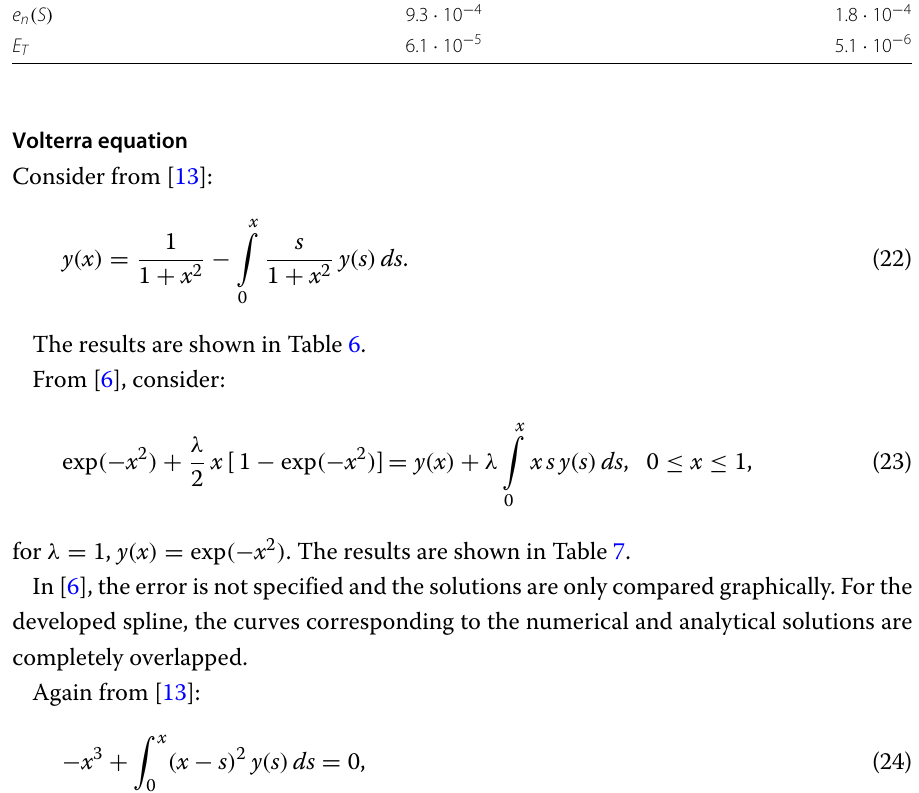
Table 6 Errors e n and E T with the S spline for (22) n